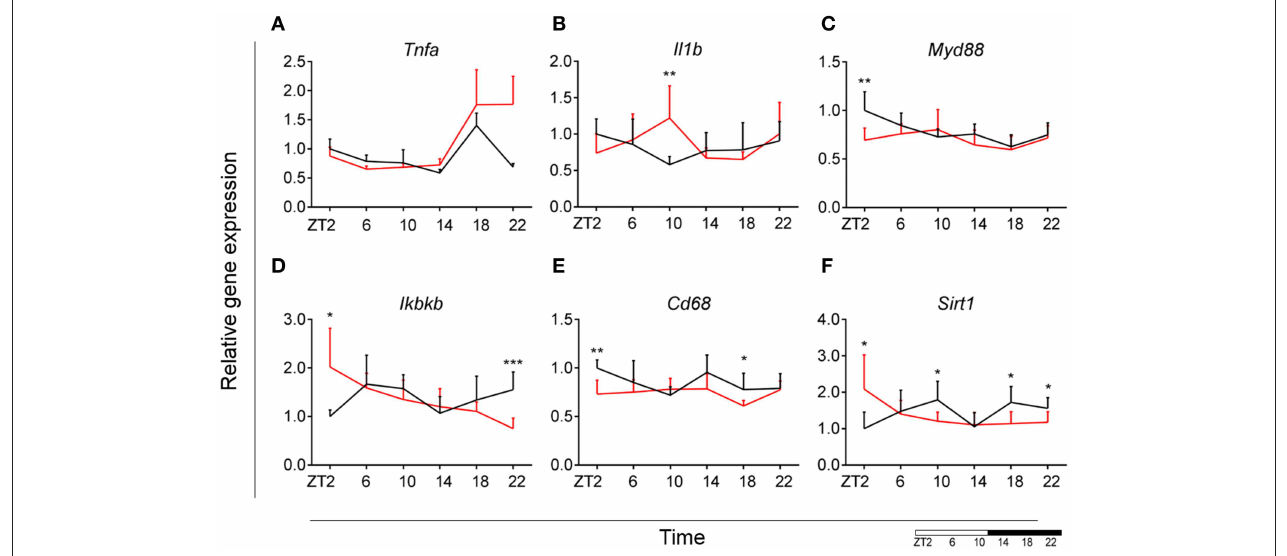
FIGURE 4 | Microglial inflammatory signaling is disturbed in DIO. Relative gene expression of innate immunity genes Tnfa (A) , Il1b (B) , Myd88 (C) , Ikbkb (D) as well as phagocytic indicator gene Cd68 (E) and Sirt1 (F) in HFD-fed rats (red) compared to Chow-fed controls (black) evaluated at six time points, starting at ZT2. Data are presented as means ± SEM. Statistical significance was determined using Two-way ANOVA effect for Interaction , Diet, and Time (ZT); Student t -test is used for diet effect within a separate time point (* p < 0.05; ** p < 0.01; *** p < 0.001). Scale (bottom right) represents light (ZT0-12) and dark (ZT12-24)